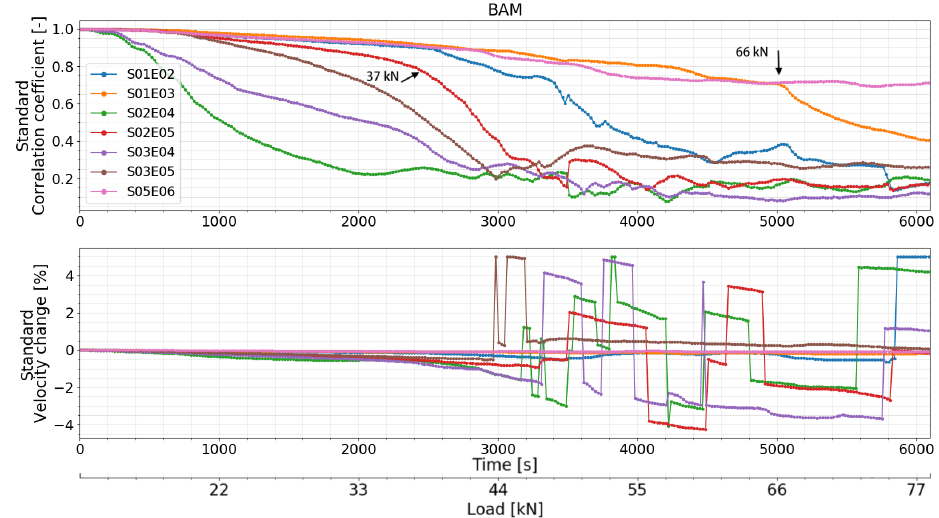
Figure 15. Correlation coefficient and relative velocity change of all the transducers combinations in test at BAM calculated by standard CWI.